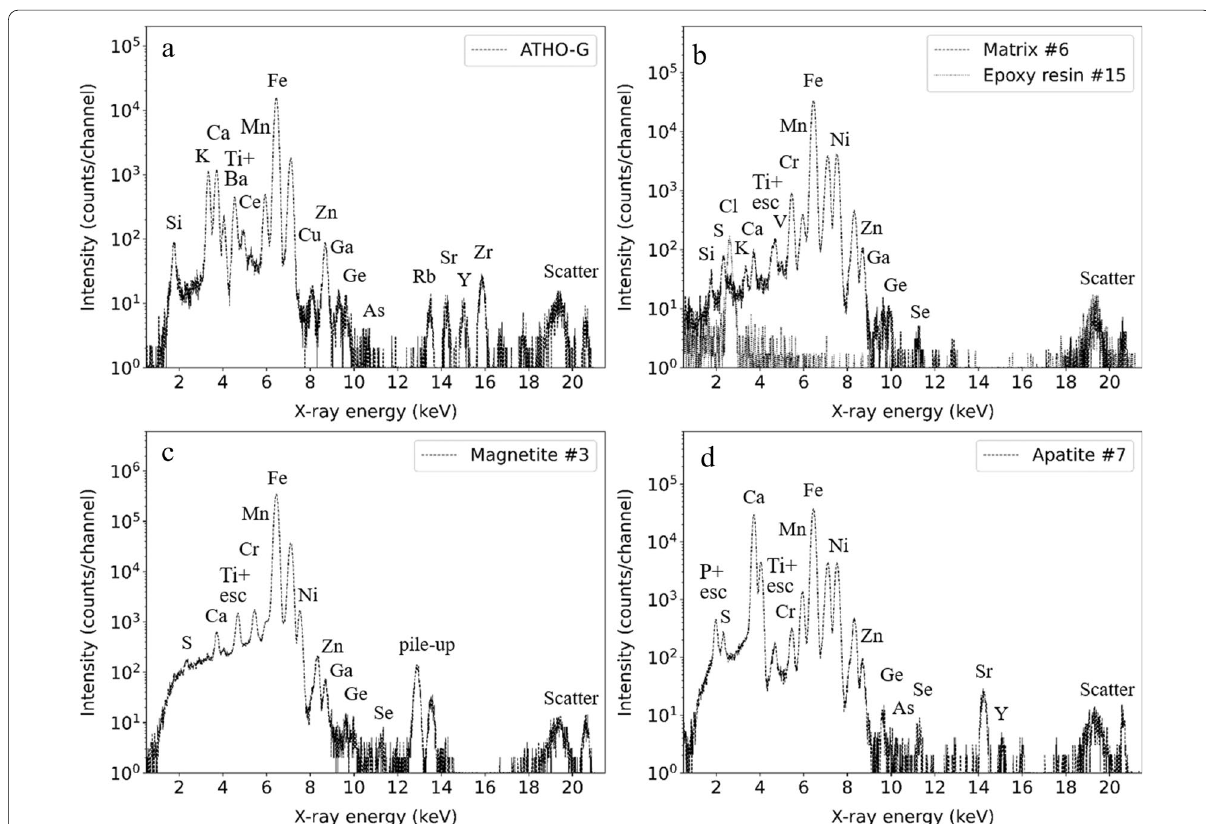
Fig. 5 a Normalized sum spectrum of a map scan performed on the ATHO‑G geological glass reference material. b Normalized sum spectra of matrix #6 and epoxy resin #15. c Normalized sum spectrum of magnetite #3, not corrected for matrix. d Normalized sum spectra of apatite #7, not corrected for